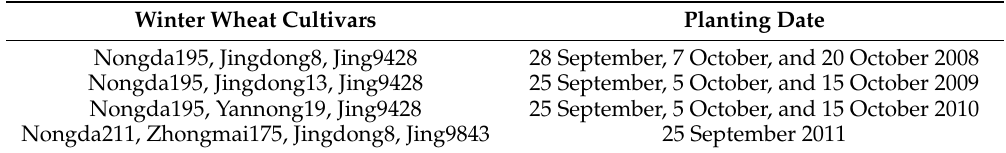
Table 1. Winter wheat cultivars and planting dates in 2008, 2009, 2010, and 2011. Winter Wheat Cultivars Planting